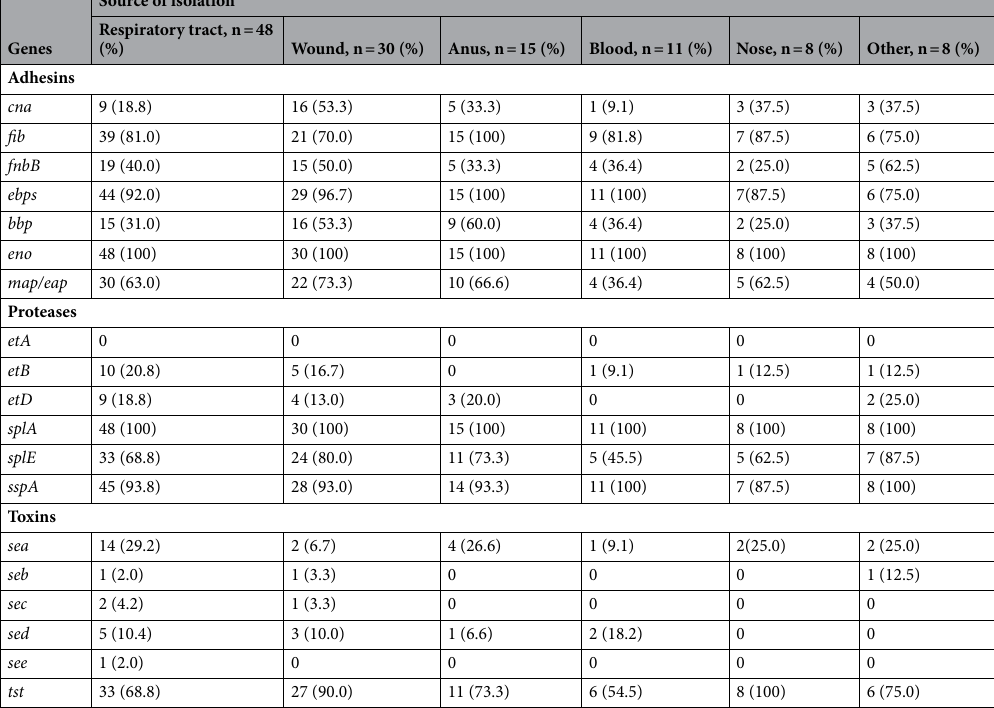
Table 3. The prevalence of virulence-associated genes in MRSA isolates from different clinical